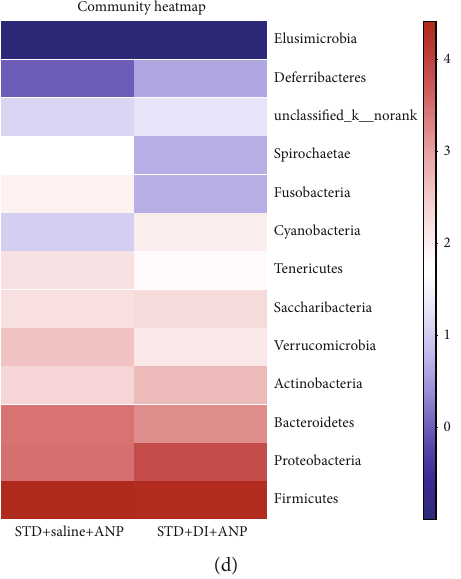
Figure 5: E ff ects of dithizone on diversity of fecal microbiota in rats on standard diet followed by retrograde sodium taurocholate infusion. (a) Estimators of intestinal microbiota α -diversity in rats treated with dithizone or saline. (b) Principal component analysis of intestinal microbiota β -diversity in rats treated with dithizone or saline. (c) Relative abundance of bacterial genera in rats treated with dithizone or saline. (d) Relative abundance heatmap of bacterial phyla in intestinal microbiota of rats treated with dithizone or saline. ∗ p < 0 : 05 , ∗∗ p < 0 : 01 , ∗∗∗ p < 0 : 001 , Student ’ s t -test. n = 8 for each